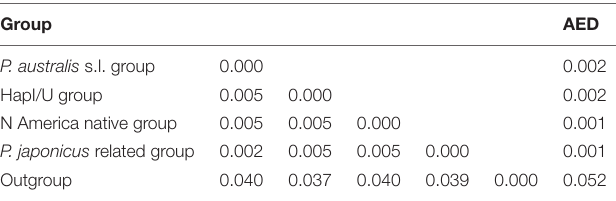
TABLE 2 | Estimates of average evolutionary divergence over sequence pairs between groups (lower left matrix) and within groups (AED).